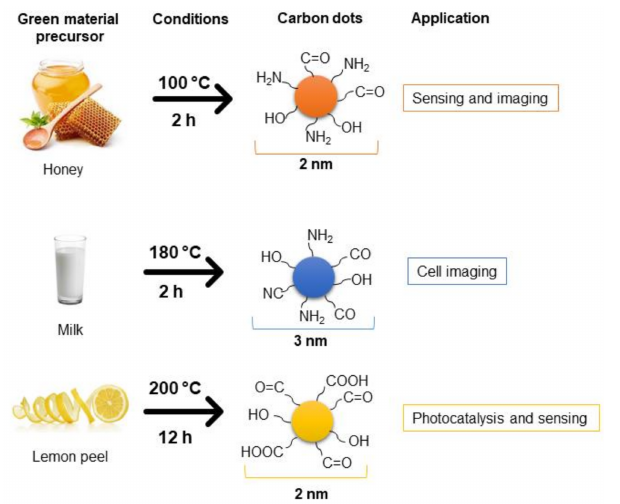
Figure 2. Schematic illustration of synthesis of carbon dots made of natural precursors. Adapted from